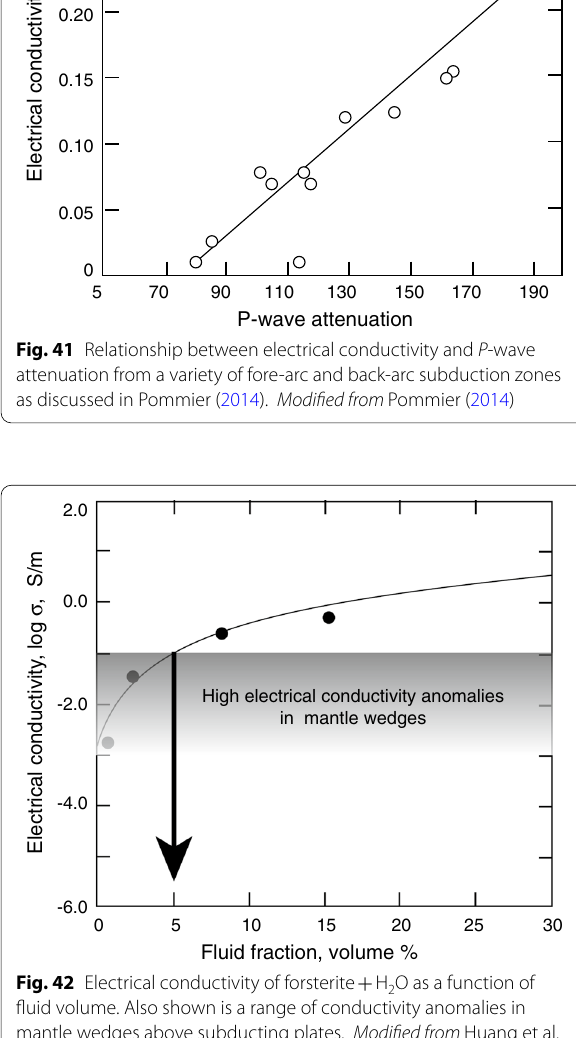
H 2 O as a function of +